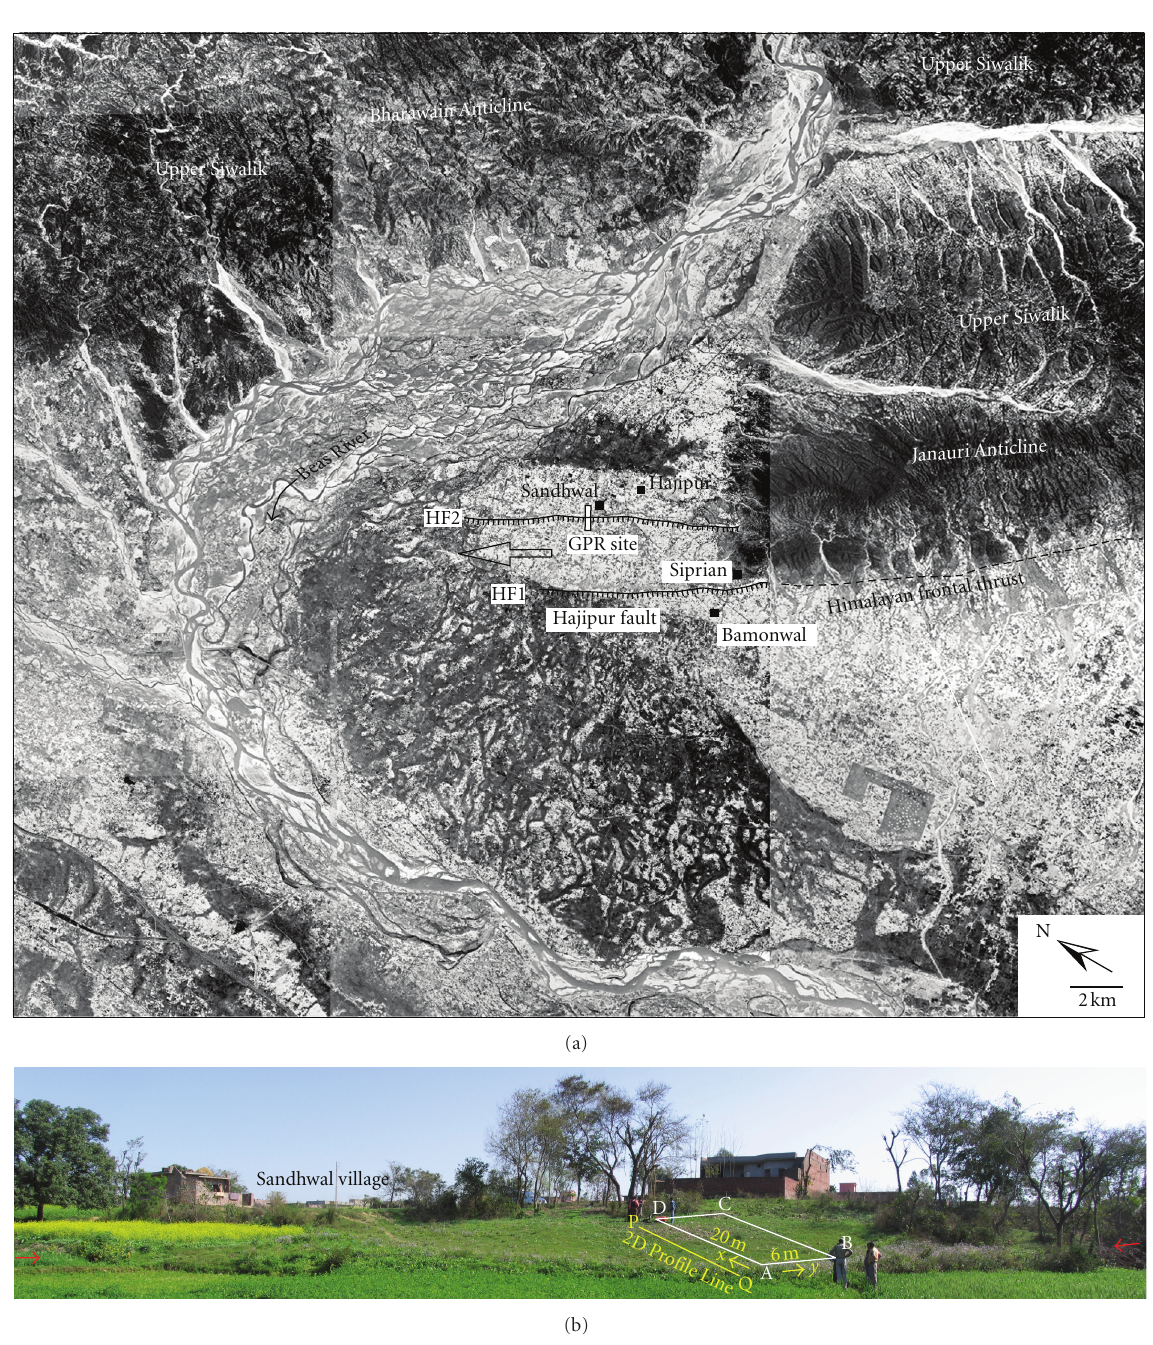
Figure 2: (a) CORONA satellite photo showing distribution of active fault traces named as “Hajipur faults”—HF1 and HF2 on the left bank of Beas River near Hajipur village [25]. Box shows the location of trench and GPR profile line across the HF2 fault scarp at Sandhwal village. Empty arrow marks the direction of fault propagation towards NW. Young tectonic movements along HF1 and HF2 faults resulted into uplift of floodplain deposits, responsible for the shifting/deflection of the Beas River channel along it present course. (b) Panoramic view of HF2—Hajipur fault scarp. PQ indicates the 2D scan, and ABCD indicates the 3D grid collected, respectively across the fault which is marked in red